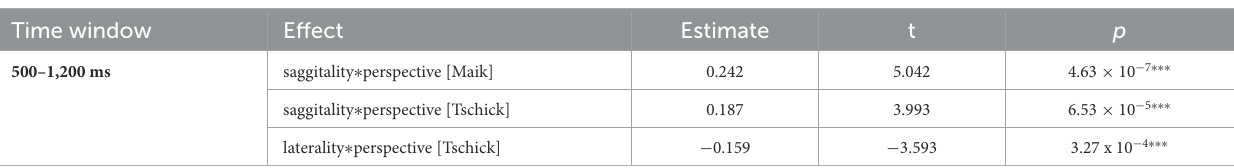
TABLE 2 Overview of significant interactions with the factor